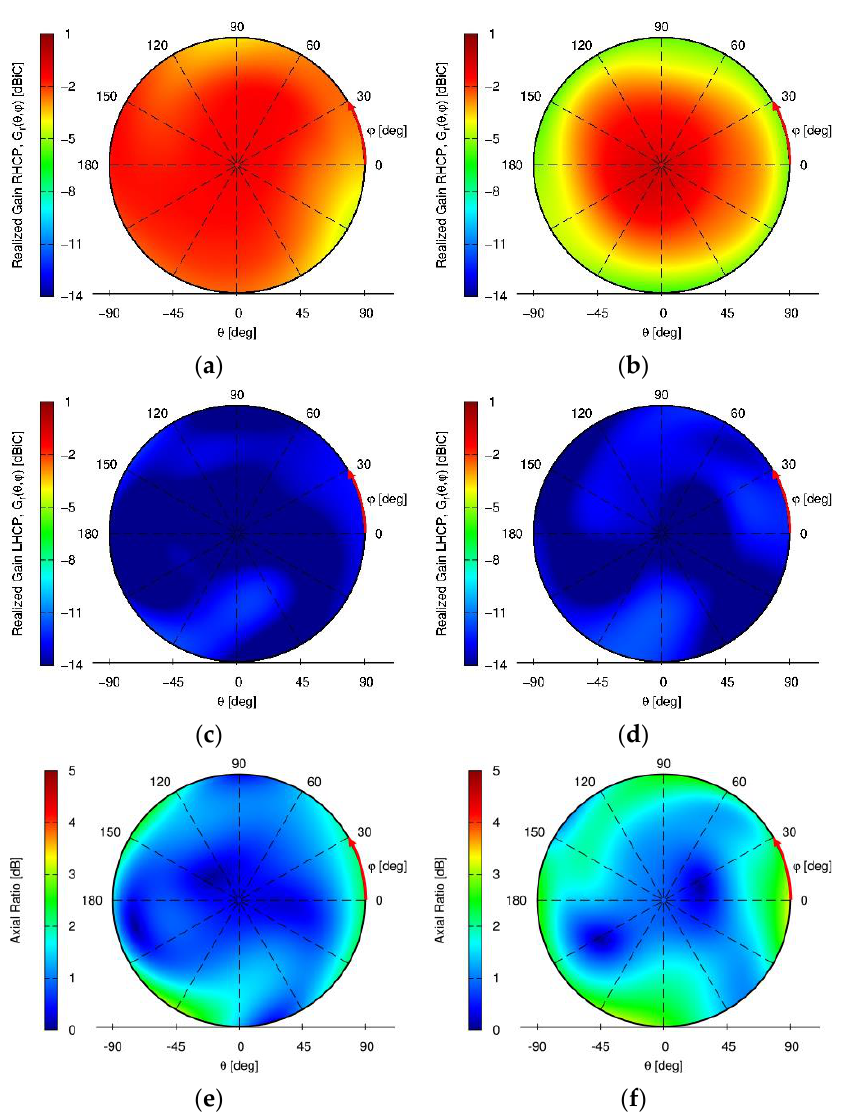
Figure 4. Measured miniaturized wideband GNSS antenna array measurement results of the array- mode radiation pattern. ( a ) Right hand circular polarization (RHCP) realized gain at L5/E5a; ( b ) RHCP realized gain at L1/E1; ( c ) left hand circular polarization (LHCP) realized gain at L5/E5a; ( d ) LHCP realized gain at L1/E1; ( e ) axial ratio (AR) at L5/E5a; ( f ) AR at L1/E1.